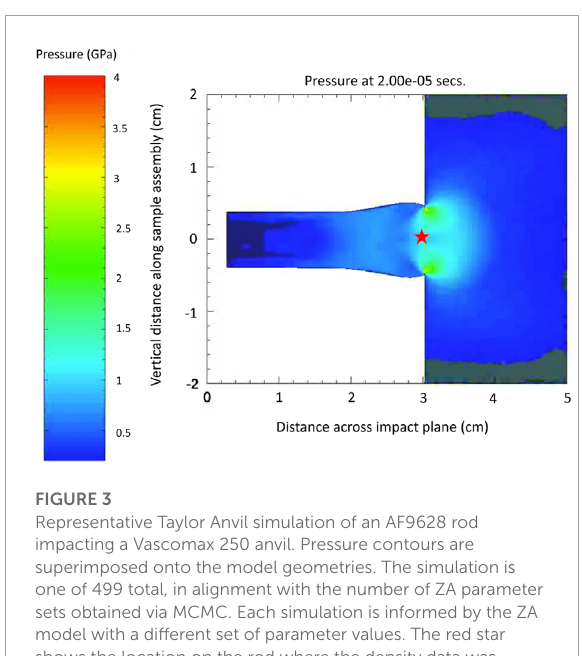
FIGURE 3 Representative Taylor Anvil simulation of an AF9628 rod impacting a Vascomax 250 anvil. Pressure contours are superimposed onto the model geometries. The simulation is one of 499 total, in alignment with the number of ZA parameter sets obtained via MCMC. Each simulation is informed by the ZA model with a different set of parameter values. The red star shows the location on the rod where the density data was